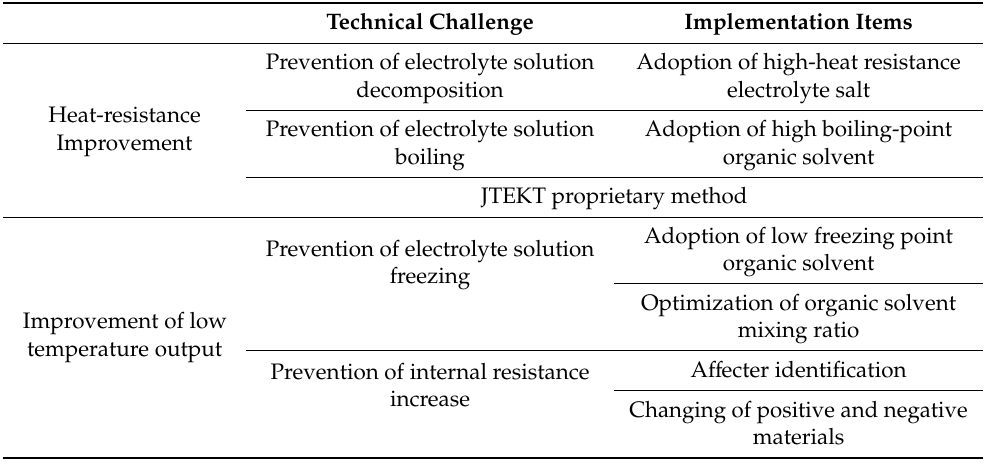
Table 1. Technical challenge and implementation